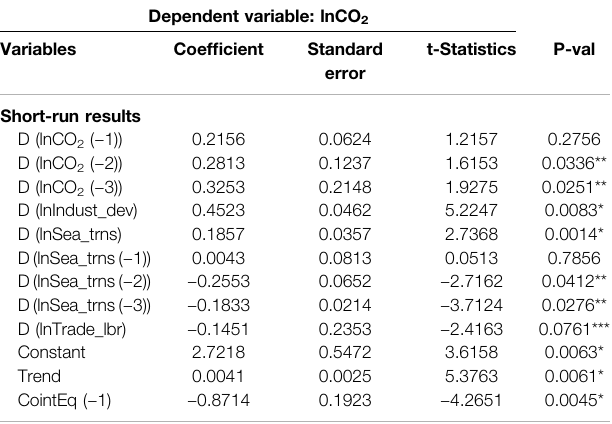
TABLE 6 | Short term ARDL results and error correction model of China.